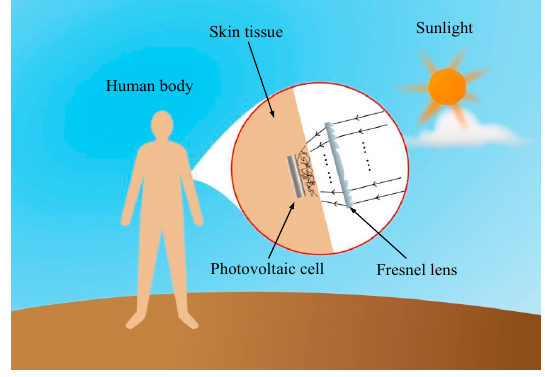
Figure 1. The recharging method of implantable biosensors using sunlight.